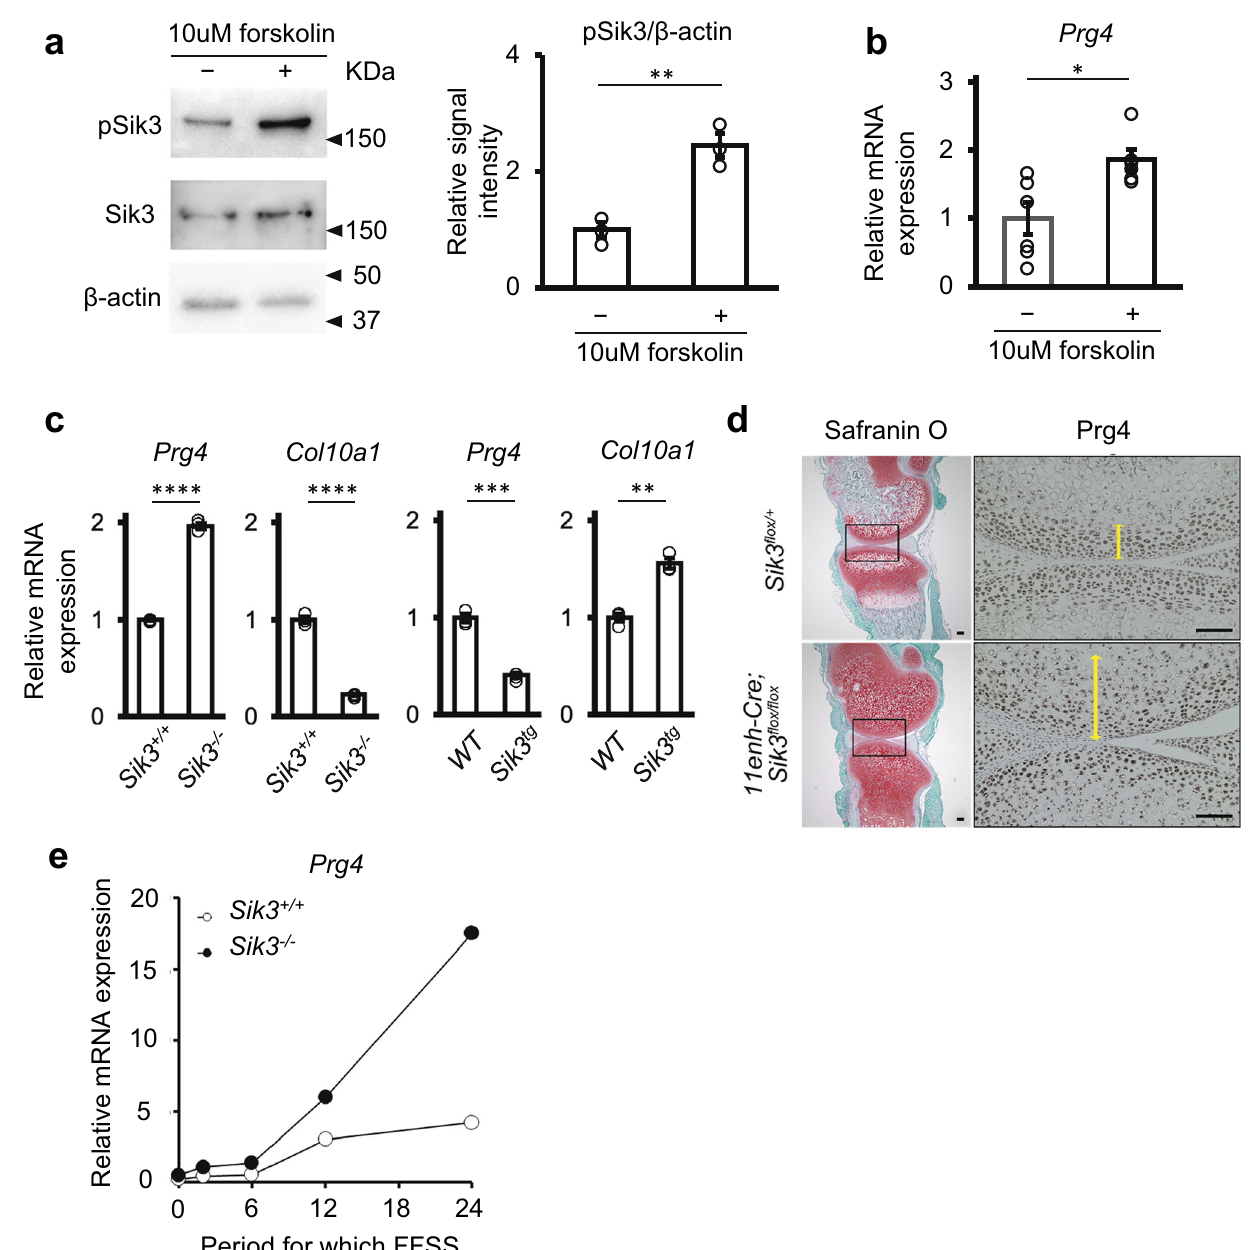
Fig. 8 | Involvement of Sik3 function and fl uid fl ow shear stress (FFSS) on Prg4 expression in mouse chondrocytes. a Immunoblot expression analysis of Sik3 phosphorylated at T411, an inactive form of Sik3, in wild-type mouse primary chondrocytes treated with 10 µ M forskolin for 30min. Left: blots representa- tive of three independent experiments are shown. Right: quanti fi cation of pSik3(pT411) to the β -actin ratio in cultured chondrocytes with or without forskolin treatment. Error bars denote mean± SE. ** P = 0.0041 by two-tailed Student ’ s t -test ( n = 3). b Real-time RT-PCR analysis of Prg4 expression in wild- type mouse primary chondrocytes treated with 10 µ M forskolin for 6h. Error bars denote mean± SE. * P = 0.0108 by two-tailed Student ’ s t -test ( n = 6 dishes). Data were representative of three independent experiments. c Real-time RT- PCR analysis of Prg4 and Col10 expression in primary chondrocytes obtained